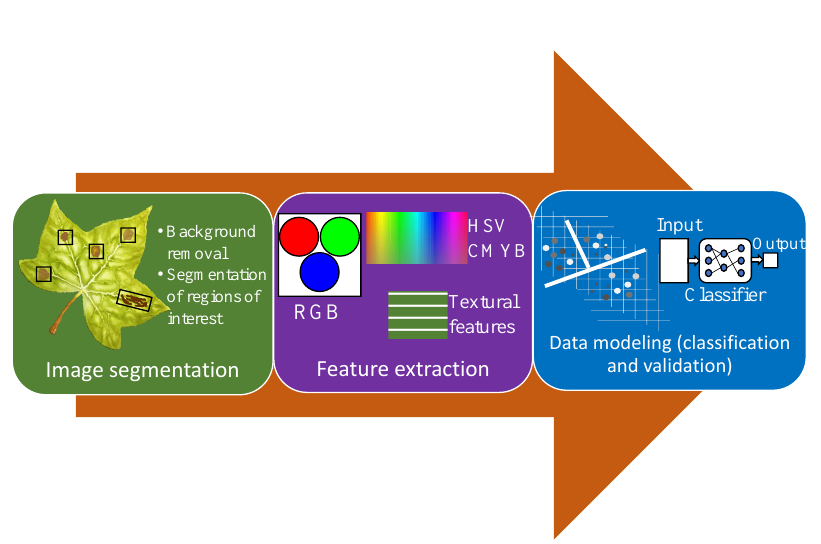
Figure 7. General workflow of visible/RGB imaging-based plant disease